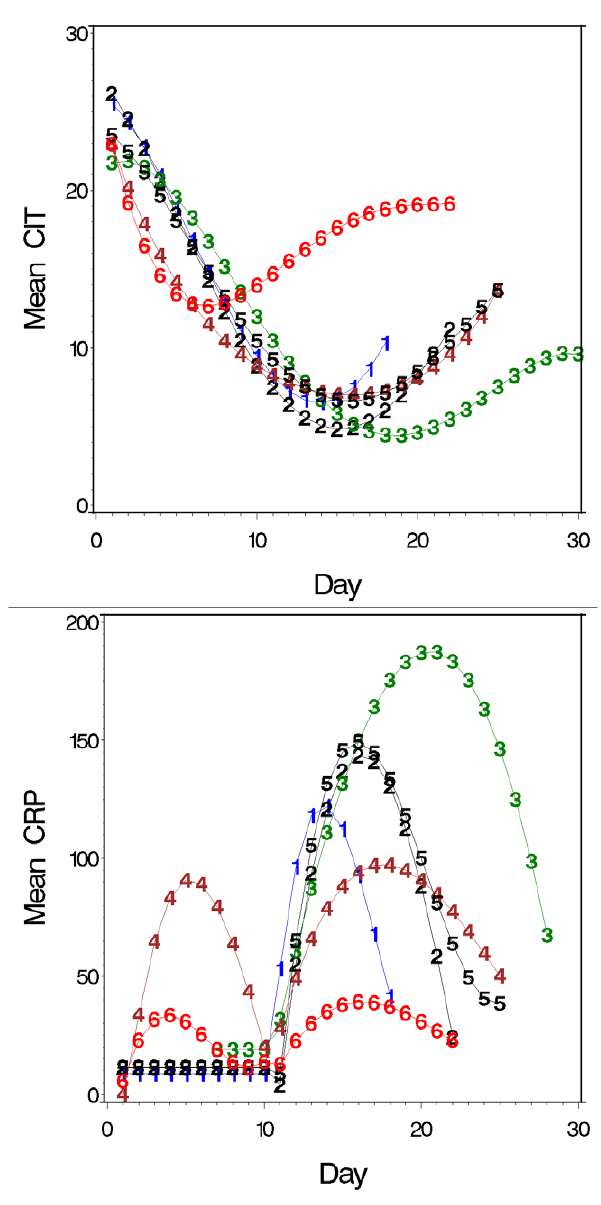
Figure 2. Summary of the time course of citrulline (A) and CRP (B) for all 6 regimens. Day 1 is the day of start of conditioning. To correct for unobserved citrulline and CRP values we modeled the course of citrulline and CRP as described in methods. 1=HDM, 2=BEAM, 3=Ida-Cyclo-TBI, 4=Cyclo-ATG-TBI, 5=Cyclo-TBI, 6=Cyclo-Flu. Mean CRP in mg/L, mean citrullline in m mol/L. doi:10.1371/journal.pone.0015156.g002 PLoS ONE |